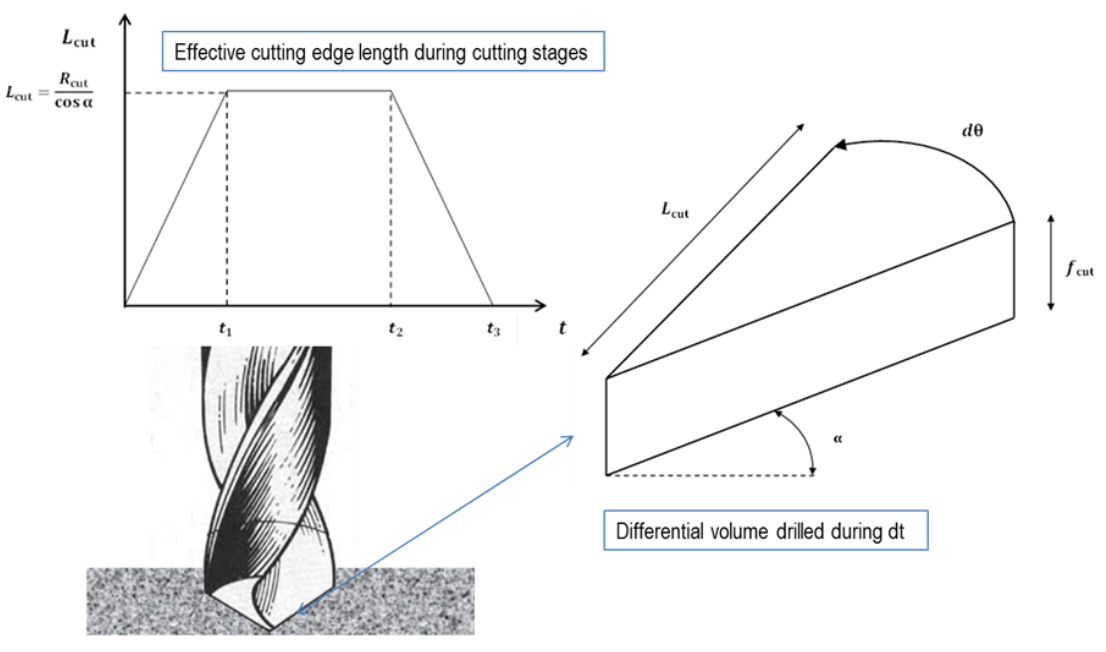
Figure 2. Scheme of drilling process: differential volume removed during the differential time d t and effective cutting edge at the different stages of drilling from entrance to drill